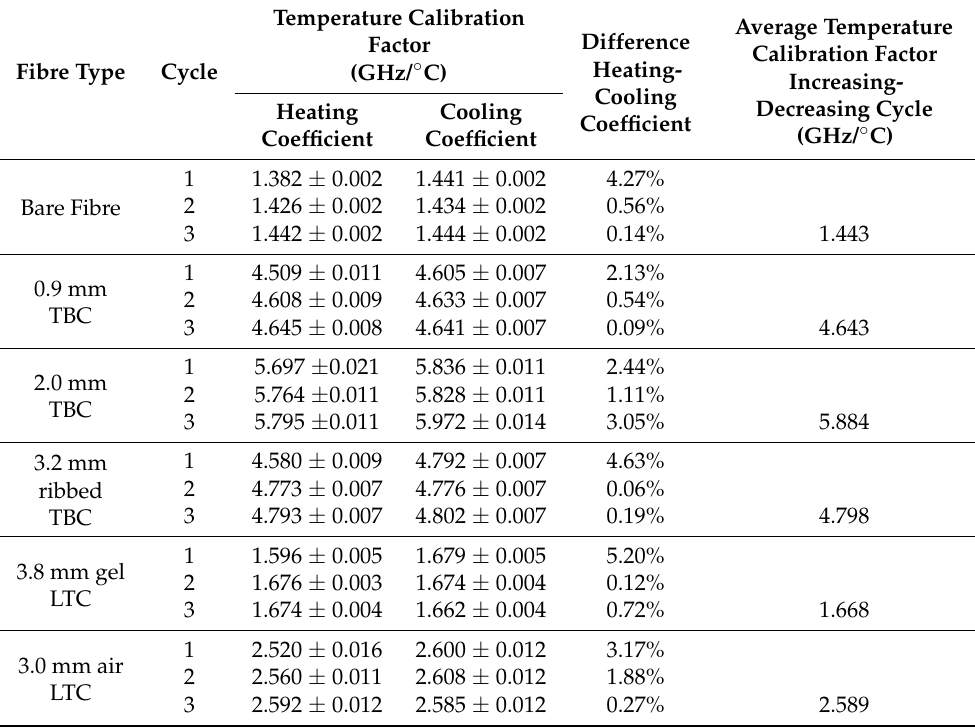
Table 4. Temperature calibration factors for tight-buffered and loose-tube